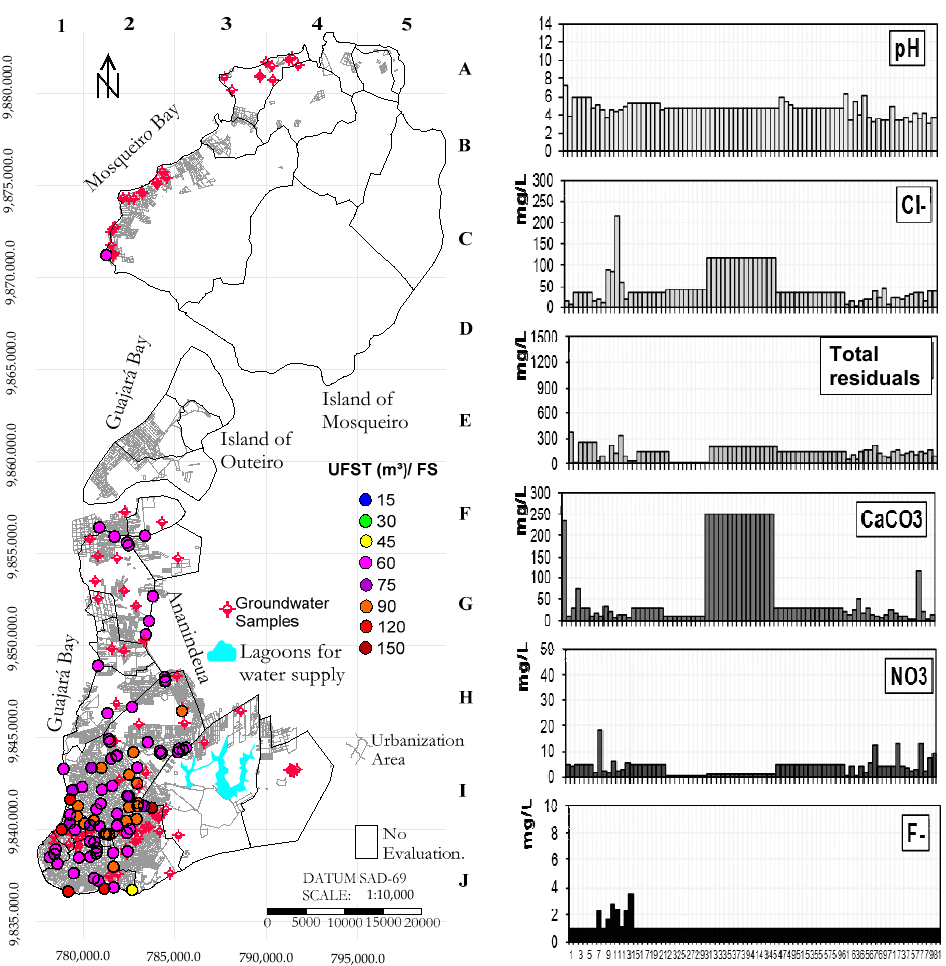
Figure 4. Spatial distribution: underground fuel storage tank (UFST) (m³)/fuel station (FS), groundwater sampling points, natural quality samples.